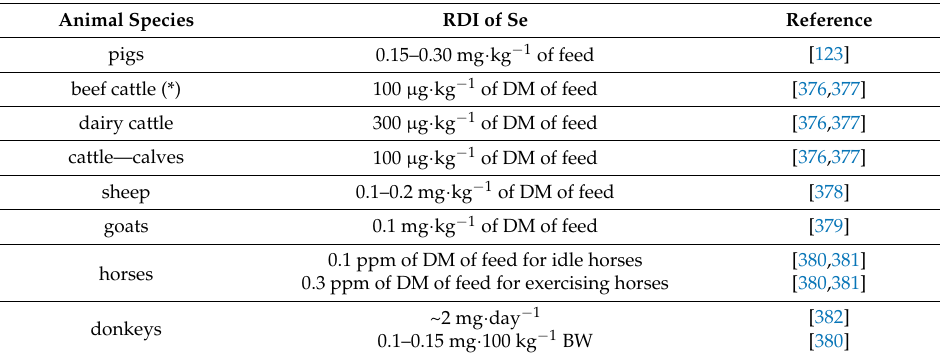
Table 1. Recommended daily intake of selenium for